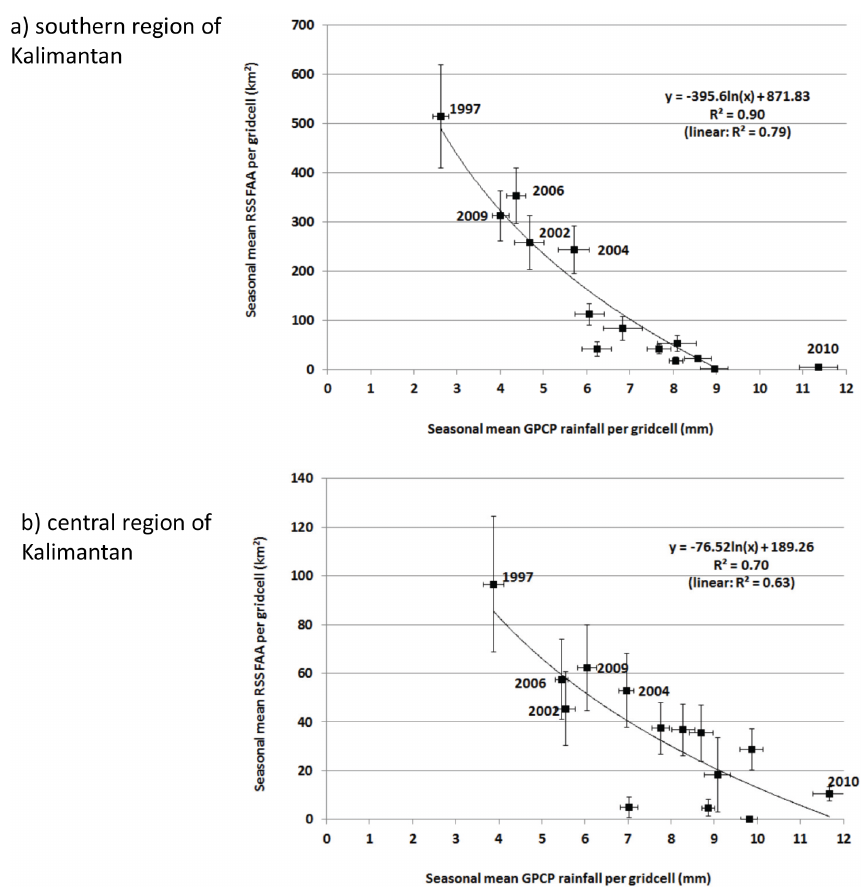
Figure 3. (a) Southern Kalimantan: seasonal mean RSS fire-affected area (FAA) per grid cell as a function of seasonal mean GPCP rainfall per grid cell; (b) central Kalimantan: seasonal mean RSS FAA per grid cell as a function of seasonal mean GPCP rainfall per grid cell. The edges of the whiskers refer to the 5th and 95th percentiles ( ± 1.96 × SE mean